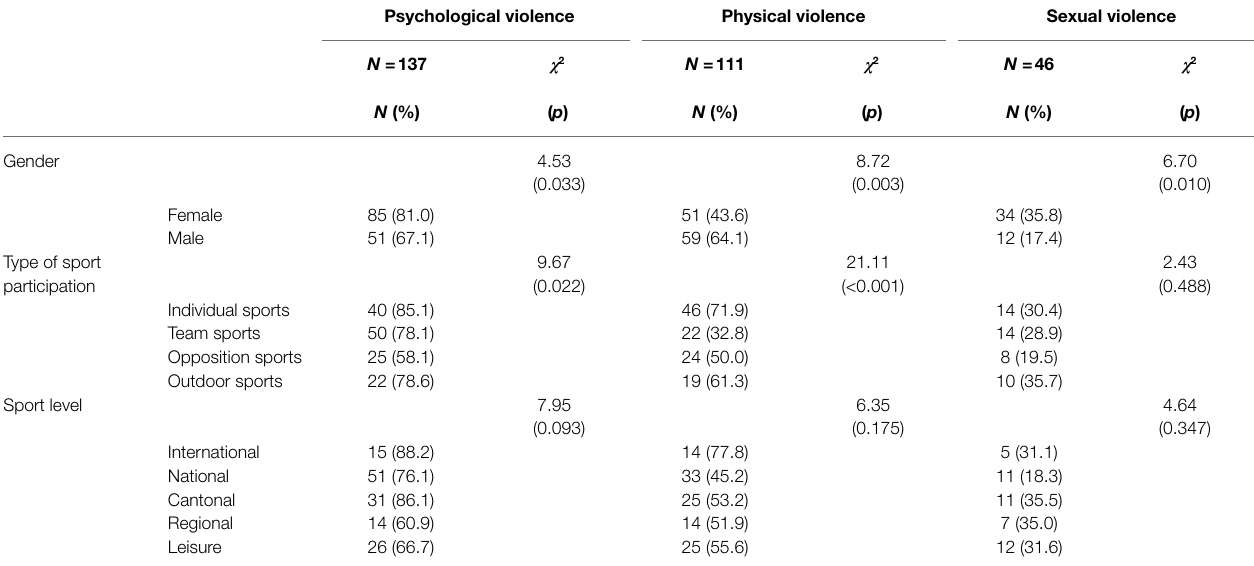
TABLE 2 | Reported prevalence of the three forms of sport-related IV per subgroup (low threshold measure, i.e., at least one experience; number and percent among subgroup with χ 2 results for distribution among subgroups).